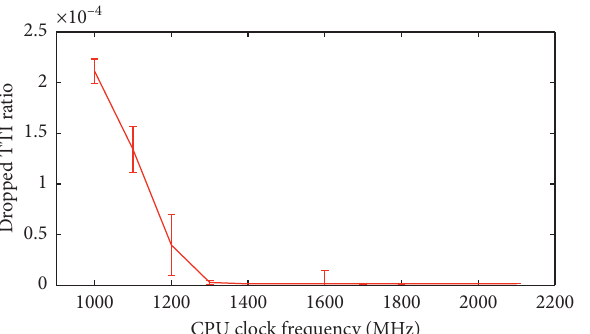
Figure 5: System 1: dropped TTI ratio for each clock frequency value recorded. The red line is the median with the vertical bars depicting ± one standard deviation. 10MHz bandwidth.